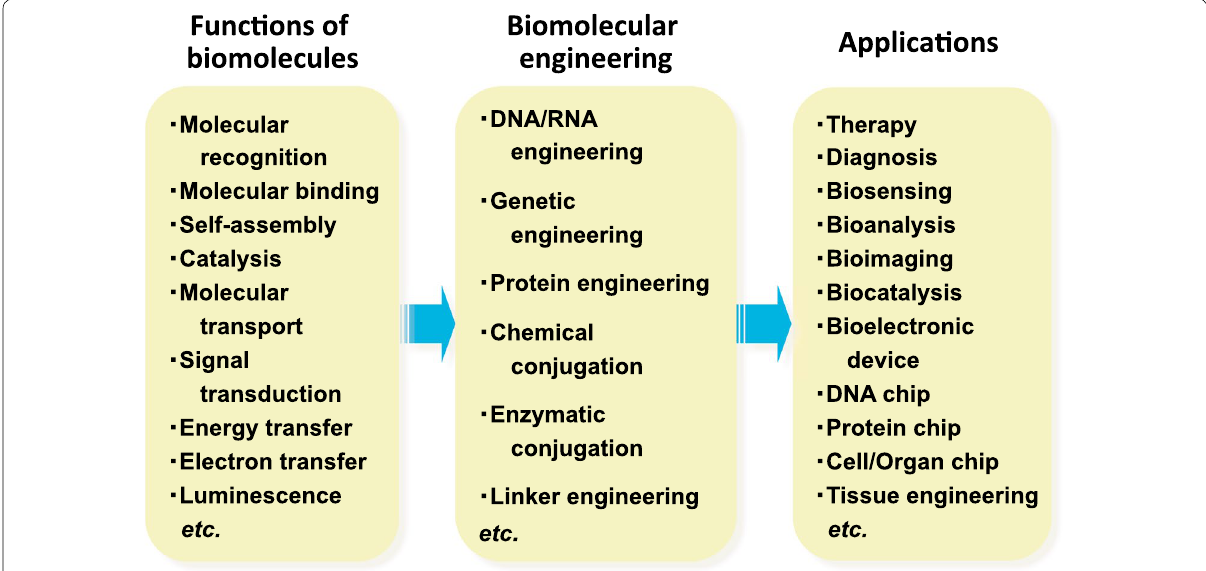
Fig. 14 Overview of biomolecular engineering for enhancing, altering and multiplexing functions of biomolecules, and its application to various